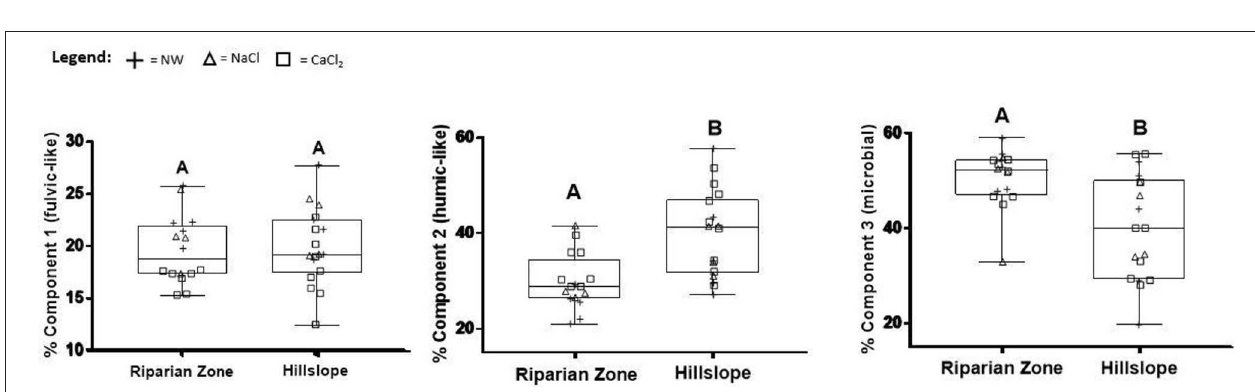
FIGURE 11 | The relative abundance of each PARAFAC component by extraction solution (NW, Nanopure water; NaCl, sodium chloride; and CaCl 2 , calcium chloride) and landscape position. Letters above the boxplots indicate significant differences according to the Tukey Multiple Comparison test at p <